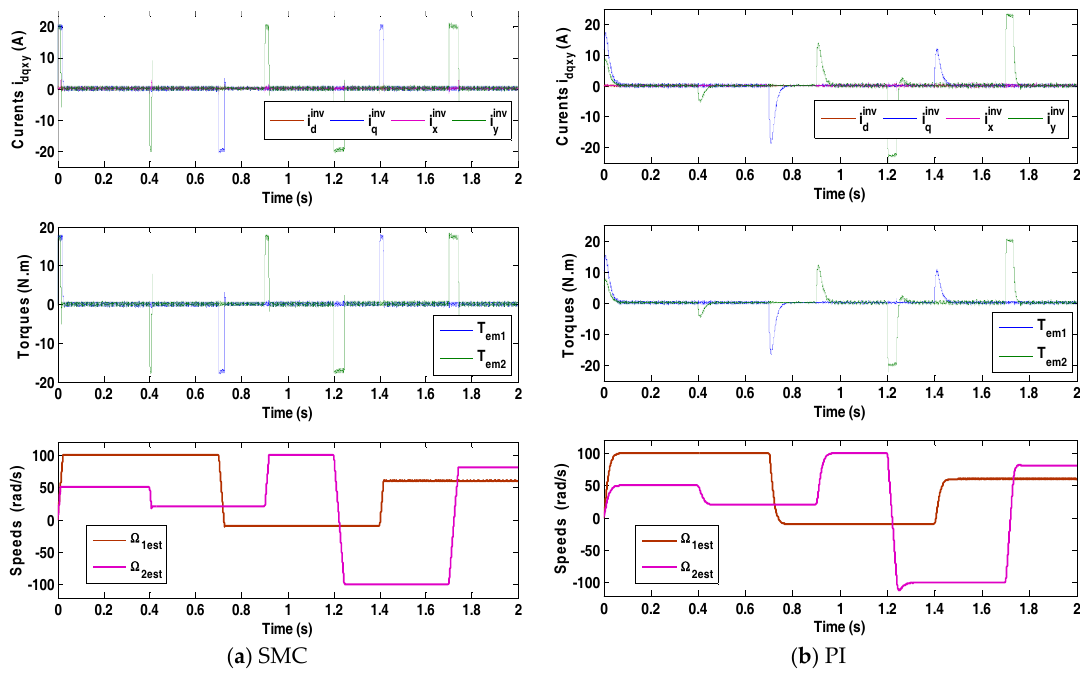
Figure 7. Dynamic responses of parallel-connected two five-phase PMSMs system at different reference speeds values.